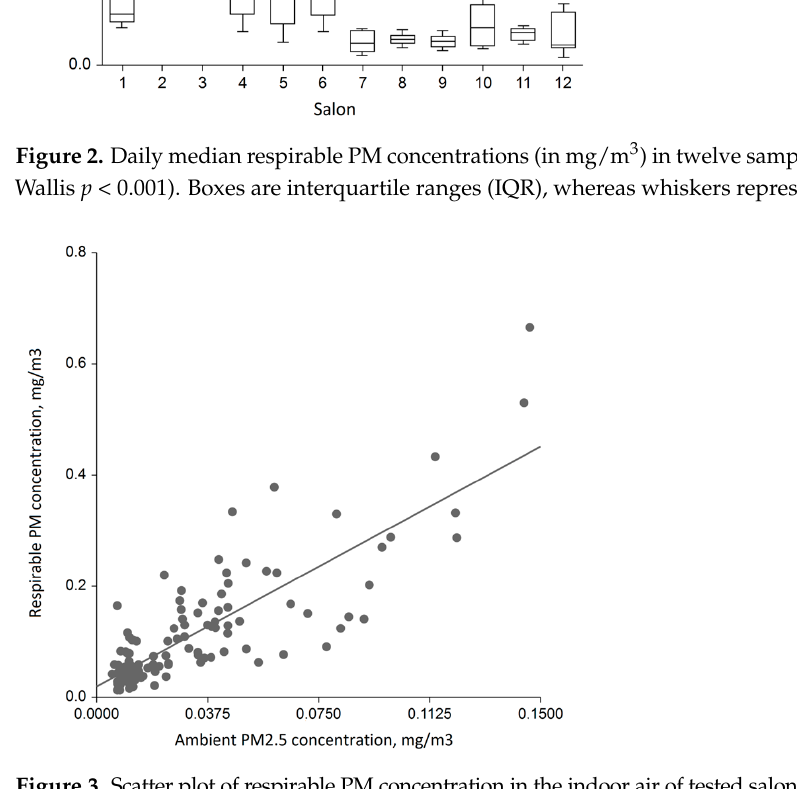
Figure 3. Scatter plot of respirable PM concentration in the indoor air of tested salons with regression line.